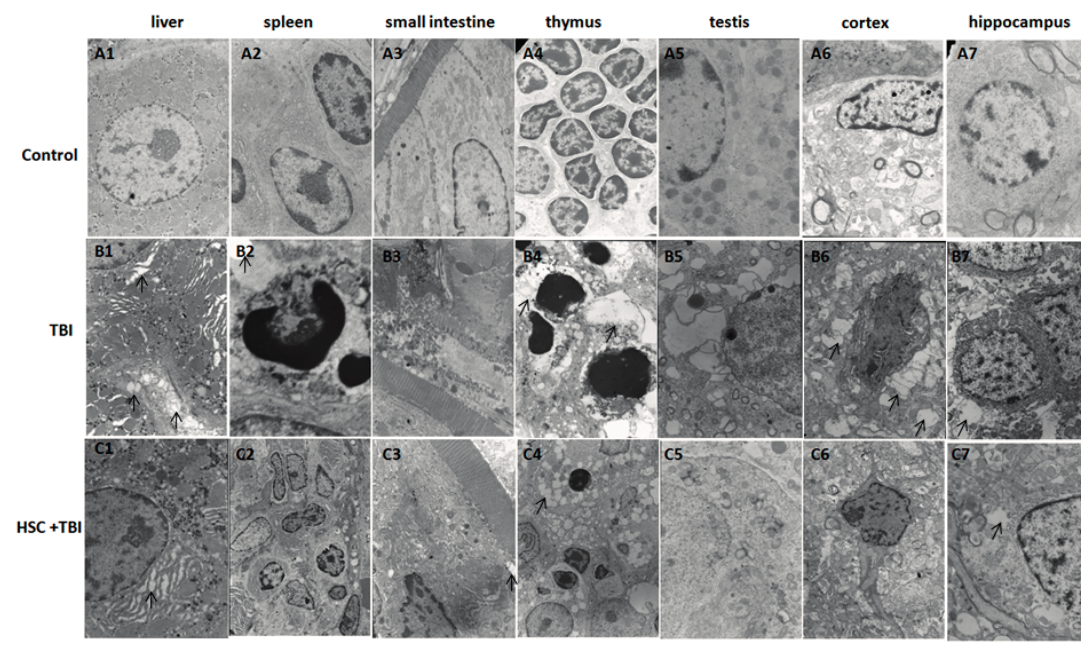
Figure 2. Effect of HSC on radiation-induced tissues injury at one day after exposure to lethal TBI (6.5 Gy) using transmission electron microscopy. ( A1 – 7 ) Representative photographs of non-irradiated rats; ( B1 – 7 ) Representative photographs of 10 TBI rats. Cell swelling and large amounts of cytoplasmic vacuoles (arrows) were observed in the different tissues at one day after exposure to lethal TBI (6.5 Gy); ( C1 – 7 ) Representative photographs of 10 irradiated rats pretreated with HSC (10 g/kg) once each day for three consecutive days before exposure to 6.5 Gy TBI. HSC pretreatment attenuated the radiation-induced tissue injury such as cytoplasmic vacuoles (arrows). (Uranyl acetate and lead citrate staining,